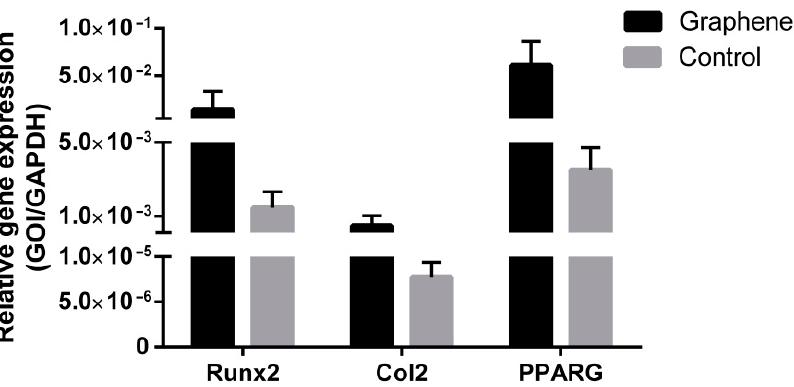
Figure 8. Gene expression evaluation of SCAP osteogenic (Runx2), chondrogenic (Col2) and adi- pogenic (PPARG) differentiation potential.